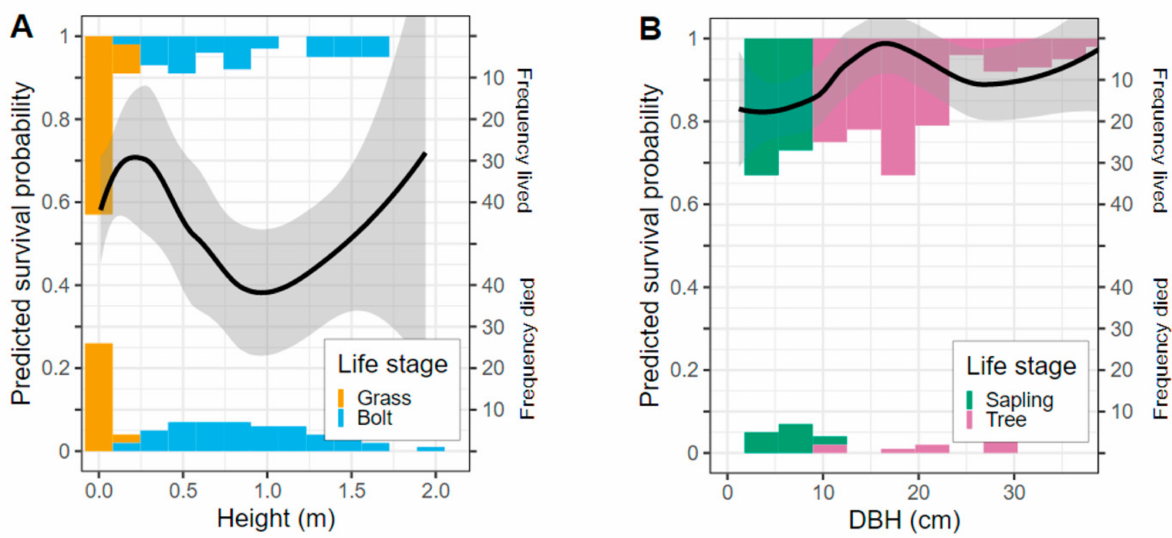
Figure 4. Longleaf pine survival probability as a function of size (height or DBH) for ( A ) grass stage and bolt stage longleaf pines, and ( B ) sapling and tree life stages. Regression lines are fit with LOWESS estimation (left axis). Note the frequency histogram axes on the right sides of the cave plots indicating the number of individuals in each size range that survived (top) or died